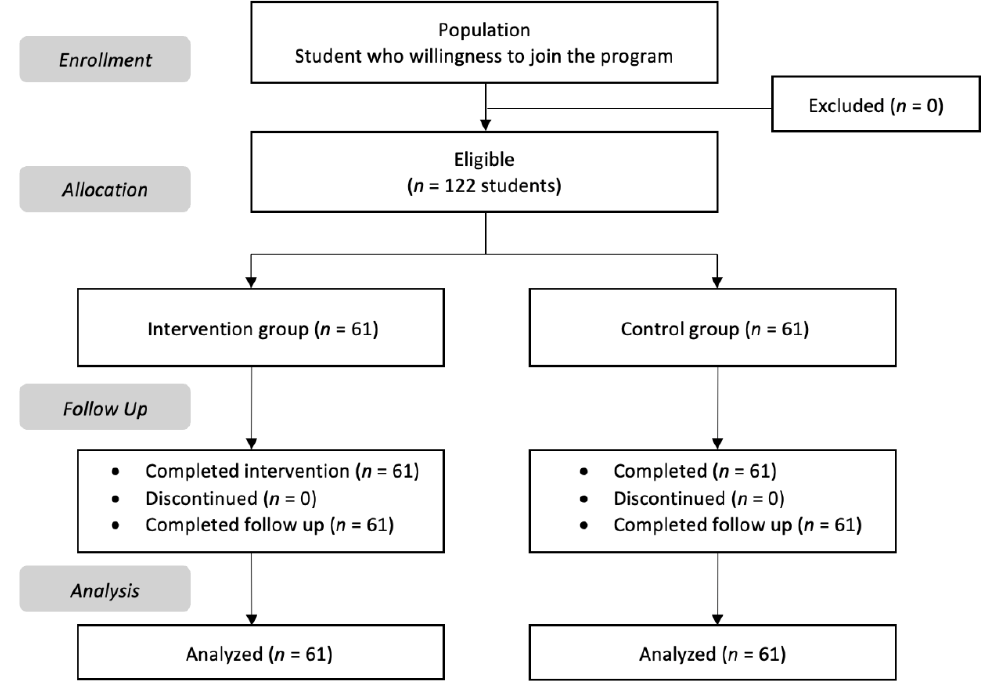
Figure 1. Consort study flow diagram.